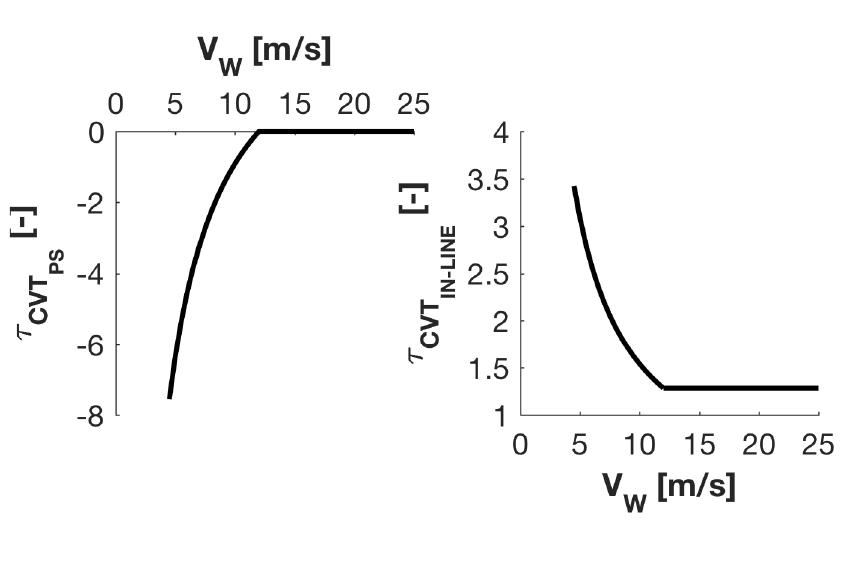
Figure 6. Transmission ratio of the ( Left ) power split HTS with a Type III power flow and ( Right ) in-line HTS.